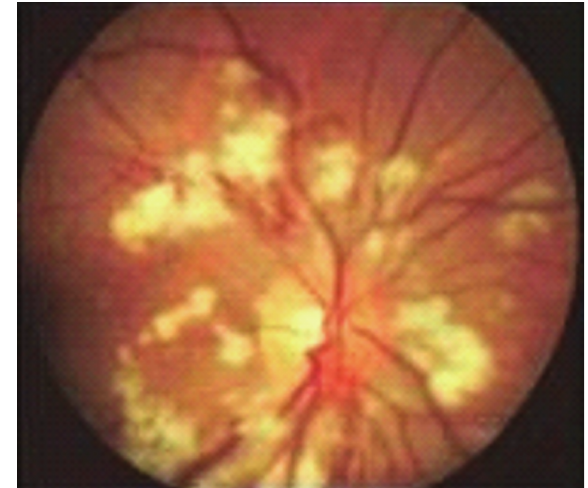
Figure 3: Fundus examination shows characteristic cotton-wool